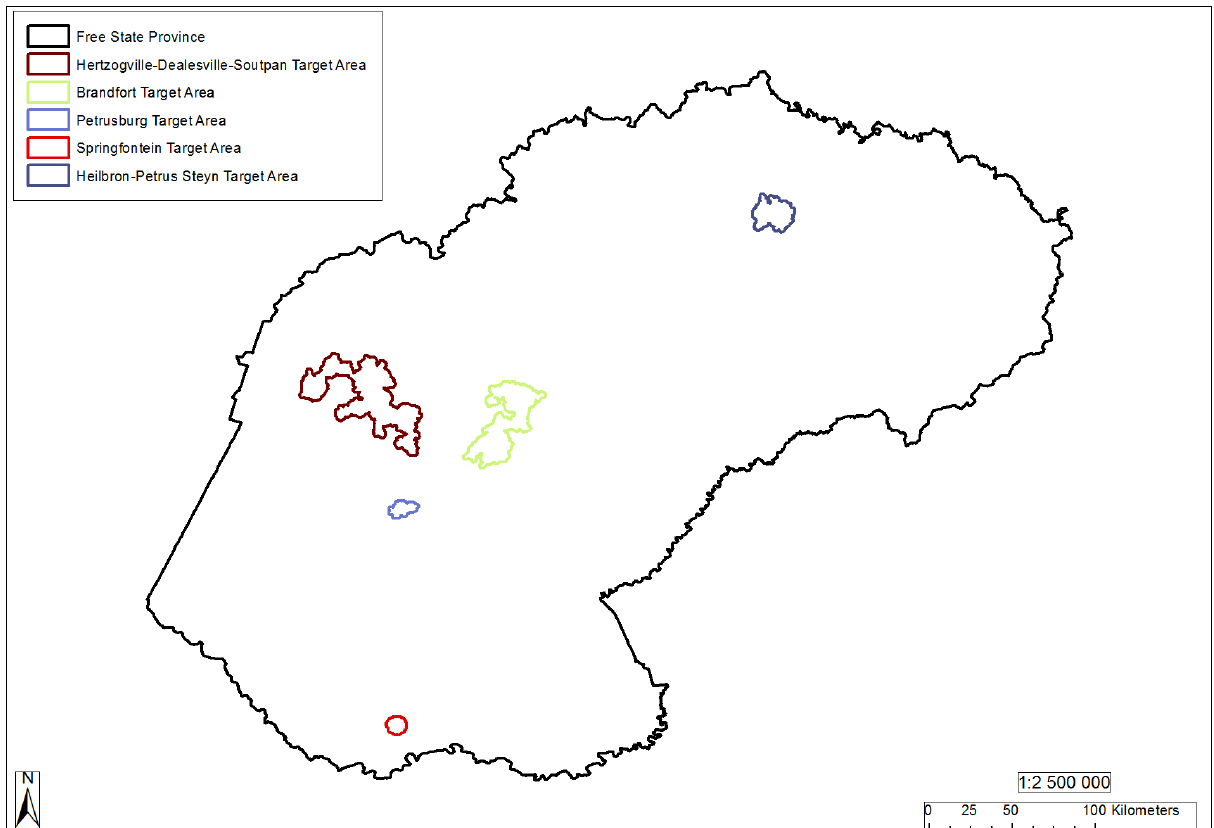
Figure 1: The five identified target areas for conservation action within the Grassland Biome of South